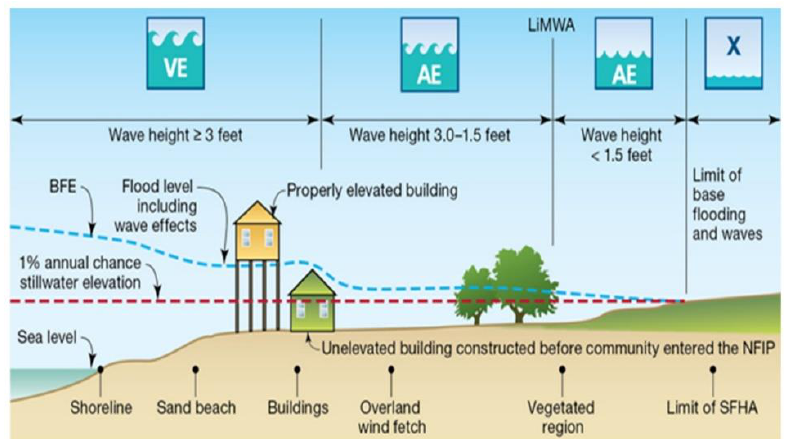
Figure 2. Federal Emergency Management Agency (FEMA) schematic of flood zones with associated water levels and wave conditions. The location of base flood elevation (BFE) and still water elevation level (SWEL) are clearly shown by the dashed blue and red lines, respectively. BFE and SWEL are referenced to NAVD88. Zone definitions are provided at the top of the figure (VE, AE, limit of moderate wave action (LIMWA), and X). http: // www.r3coastal.com / home / coastal-hazard-analysis-mapping